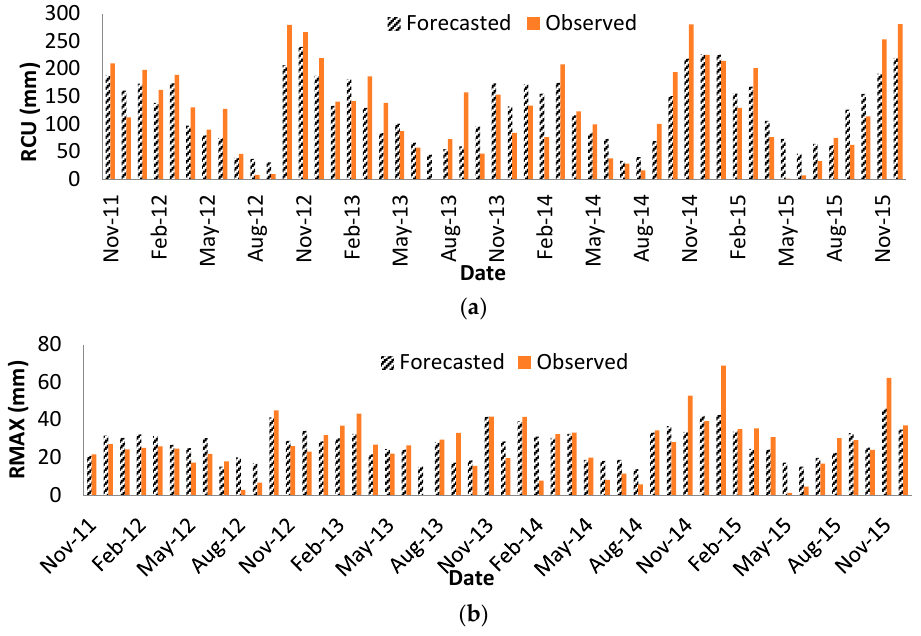
Figure 6. Comparison of the observed rainfall with the forecasted values by TOPSIS for ( a ) RCU and ( b ) RMAX.